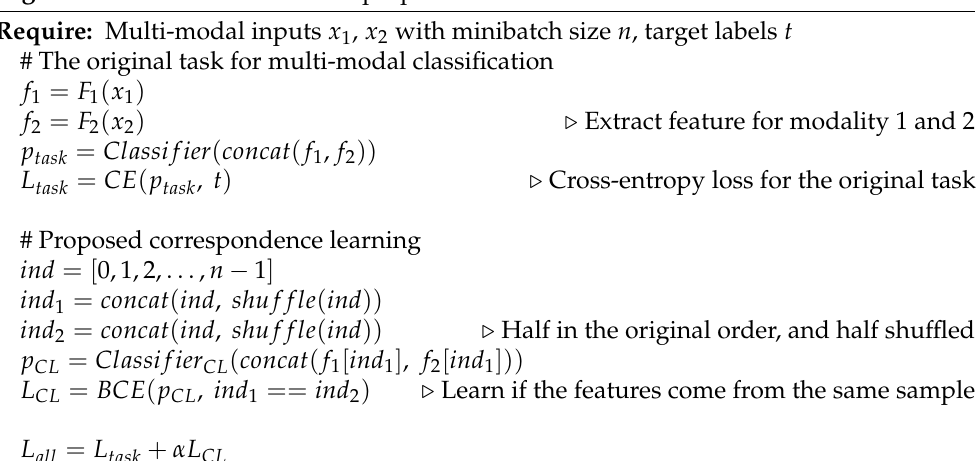
Algorithm 1 Pseudo code for the proposed